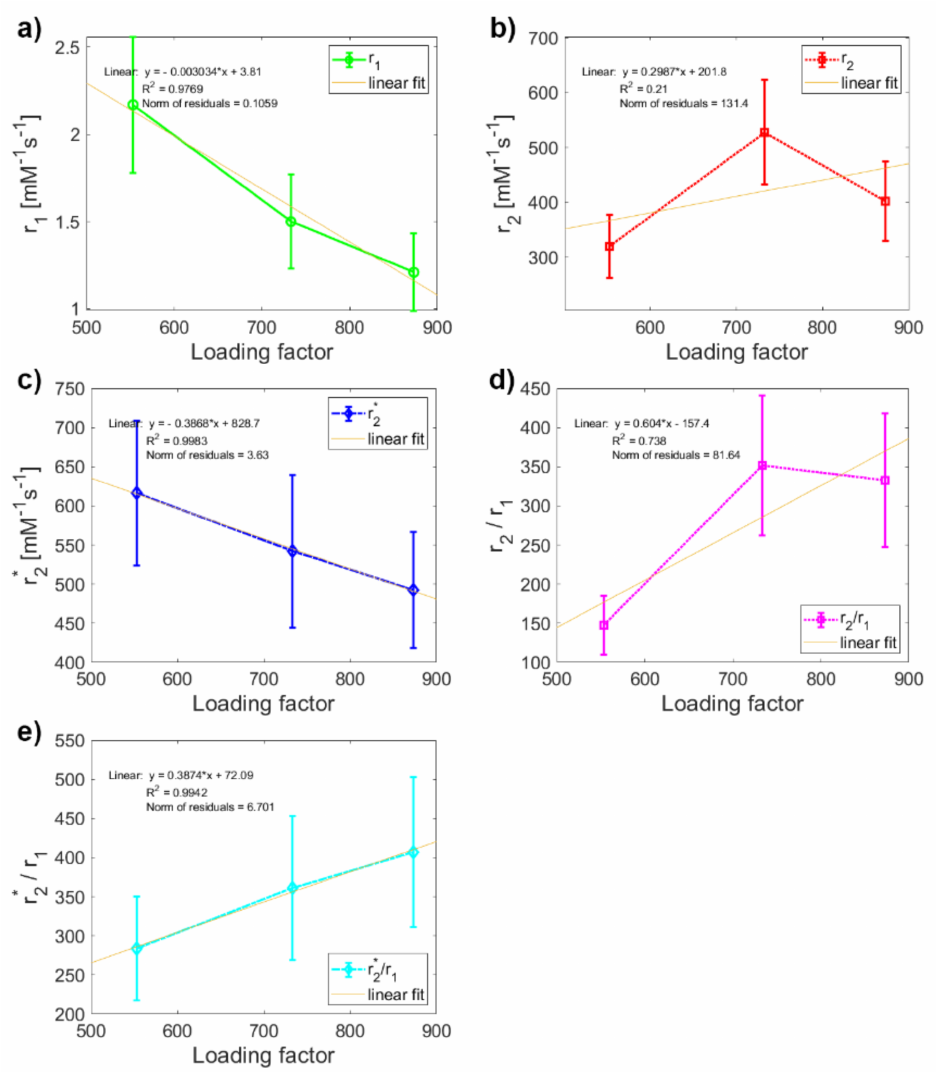
Figure 4. Linear regression analysis of the dependence of relaxivity on LF : comparison of variables Figure 3. samples: ( a ) longitudinal relaxivity r 1 ; ( b ) transverse relaxivity r 2 ; ( c ) transverse relaxivity r 2 * ; ( d ) relaxivity ratio r 2 /r 1 ; ( e ) relaxivity ratio r 2 */r 1